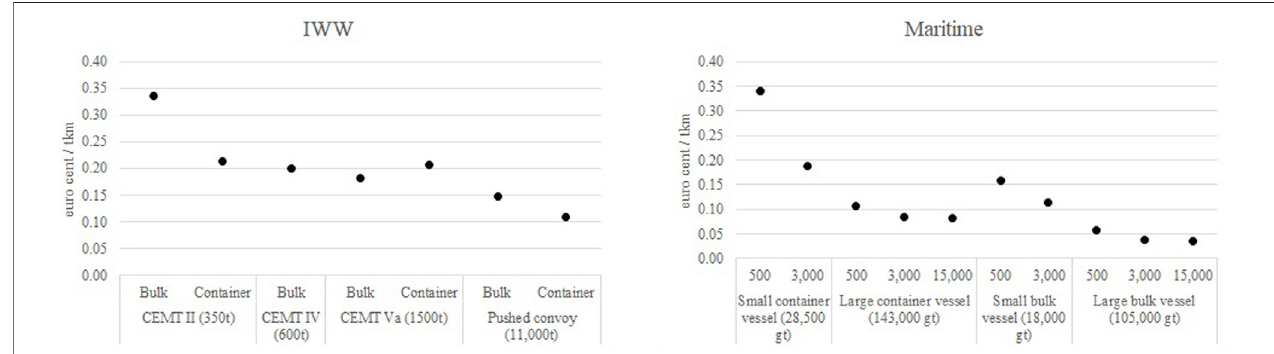
FIGURE3| Average/marginalclimatechangecostsforselectedvessels:IWW(left)andmaritime(right).Note:thenumbersofthe x -axisoftherightchartrefertothe distance at sea, measured in km. The values represent the EU27 plus United Kingdom in 2016. CEMT means “ Conférence européenne des ministres des Transports . ” Source: adapted from CE-Delft (2020) annexes downloaded 2